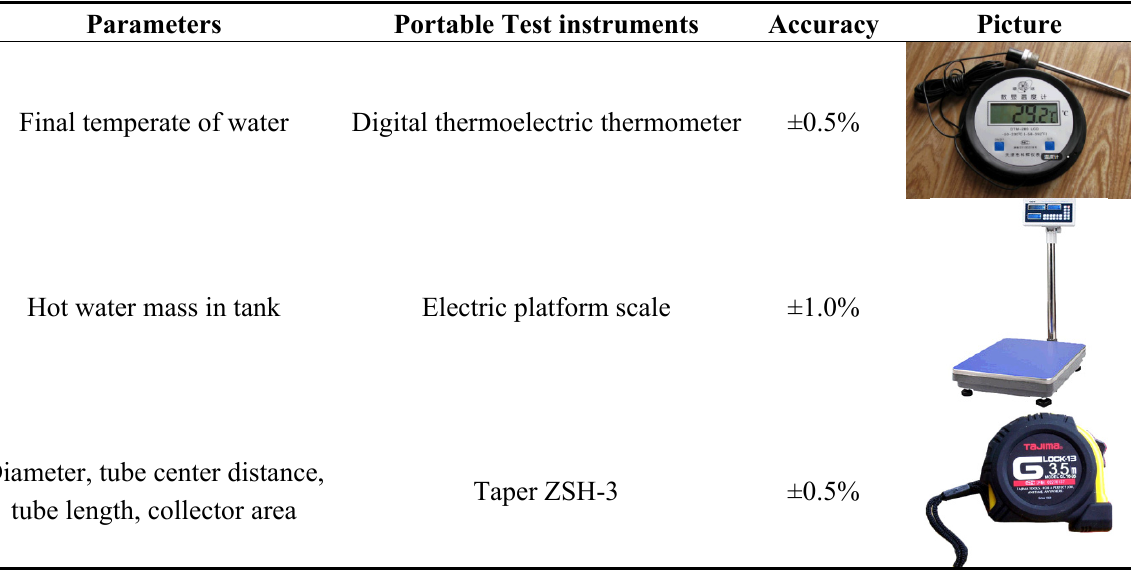
Table 1. “Portable test instruments” for the determination of parameters of water-in-glass evacuated tube solar water heaters.